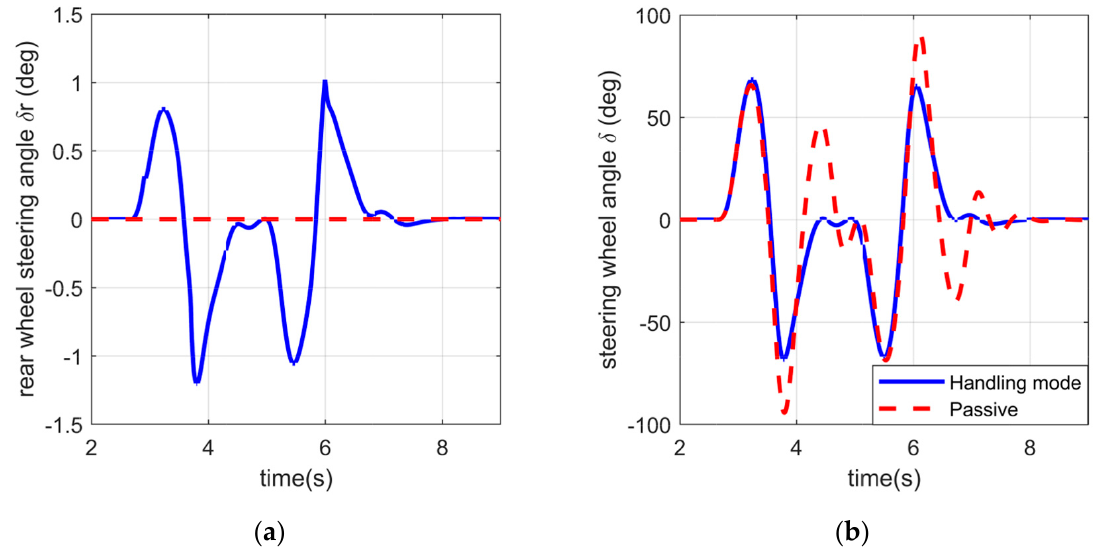
Figure 16. Steering angle for ISO 3888-1 at 80 km/h: ( a ) Rear wheel steering angle; ( b ) Steering wheel angle.